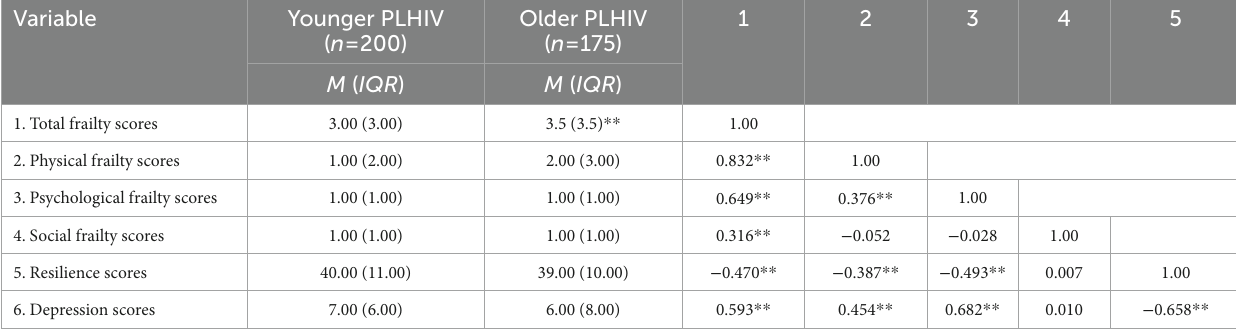
TABLE 2 Age difference and correlation among resilience, depression and frailty.